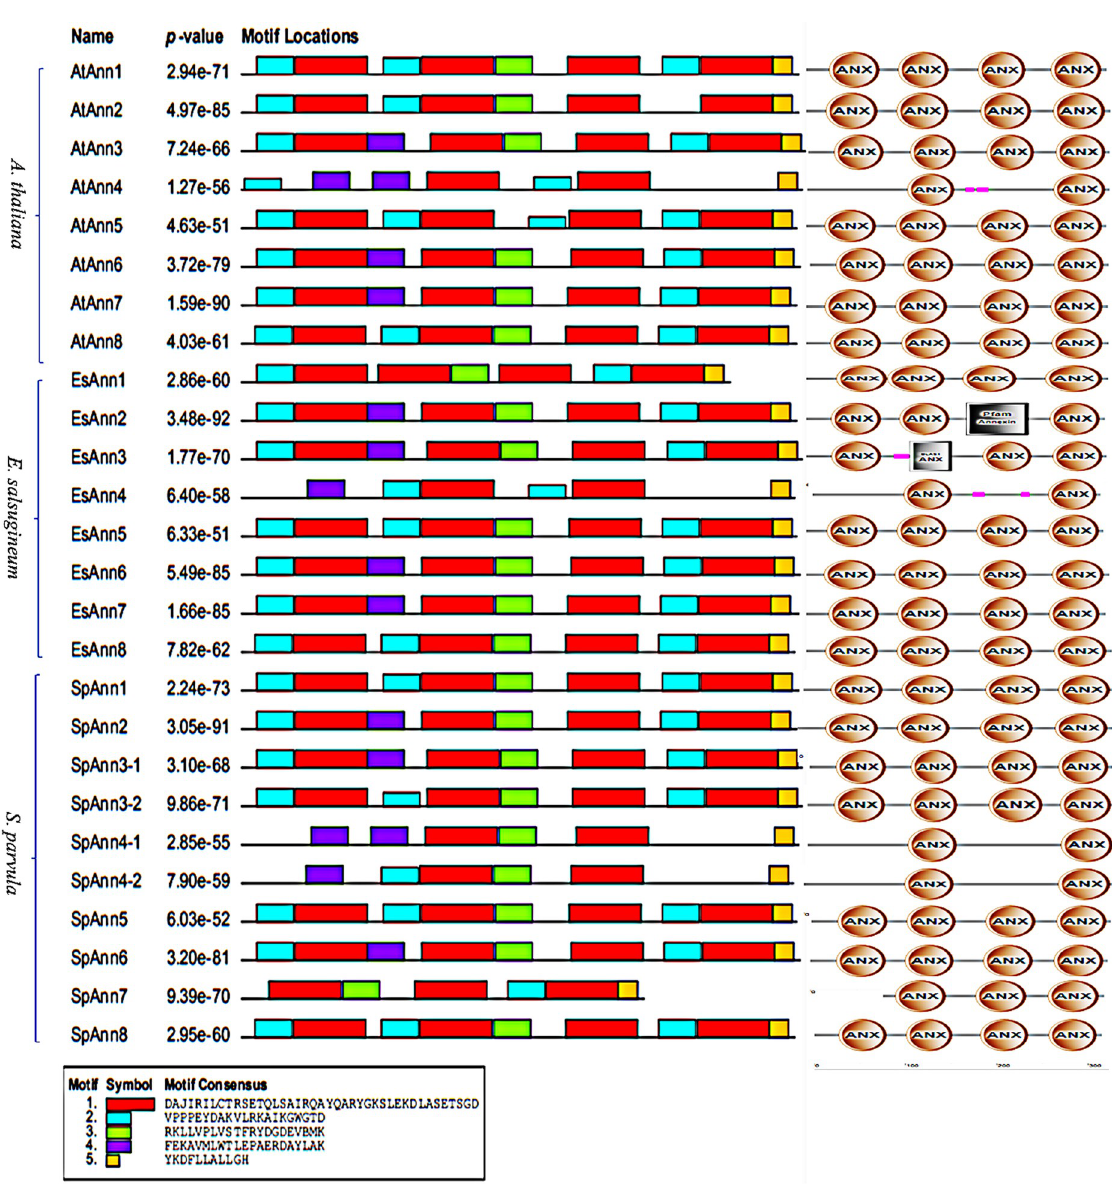
Fig 4. Motif distributions of Ann proteins in A . thaliana , S . parvula and E . salsugineum . Five motifs were identified by MEME tools. On the left, a list of Ann proteins is listed. The various colored boxes symbolize various themes and their locations within each annexin sequence. The key motif sequences are presented at the